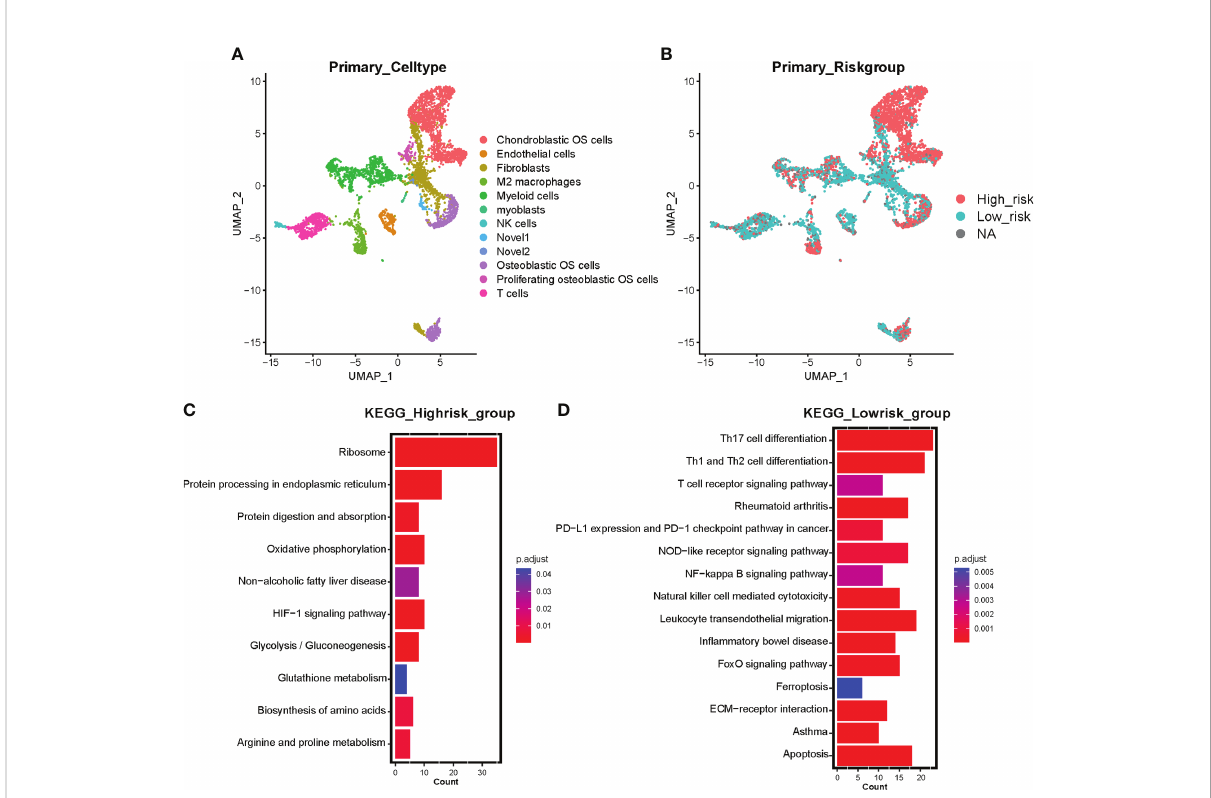
FIGURE 5 Single-cell sequencing investigating the correlation between risk signature and tumor microenvironment in primary OS samples. (A) UMAP visualization exhibits 12 annotated cell clusters based on primary OS single cell sequencing. (B) Risk cell clustering by ferroptosis signature clusters all cells into high-risk cells and low-risk cells. Red represents high-risk cells and blue represents low-risk cells. NA represents partial signature genes were not expressed in the single-cell sparse matrix. (C) KEGG enrichment analysis based on marker genes of high-risk cells. (D) KEGG enrichment analysis based on marker genes of low-risk cells. Color represents adjusted p value (Benjamini-Hochberg), the darker the red, the higher the signi fi cance; the darker the blue, the lower the signi fi